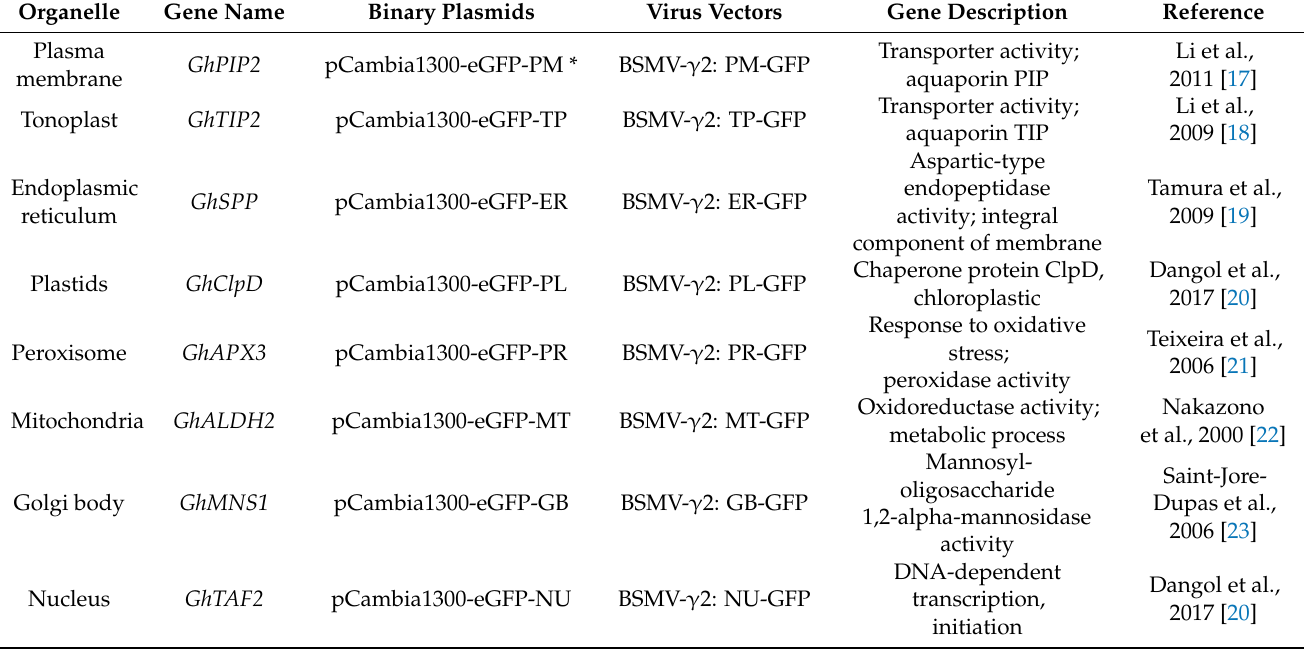
Table 1. Selected organelle marker genes and plasmids containing green fluorescent